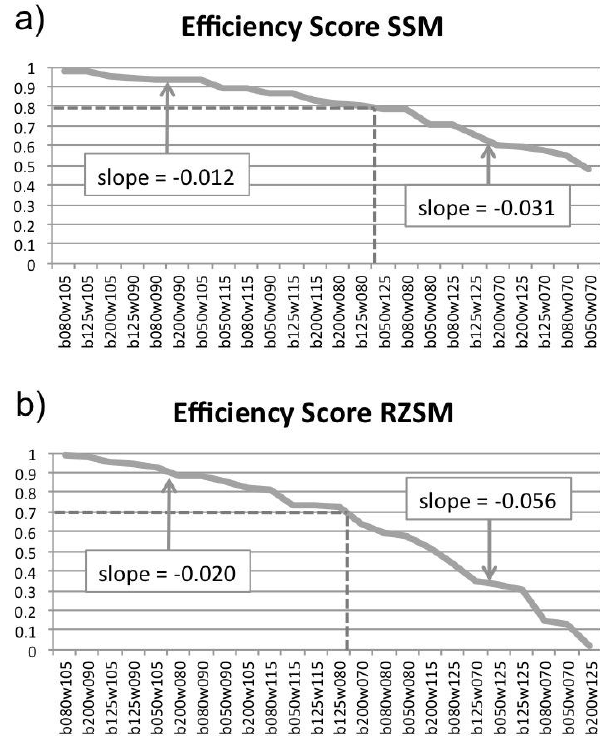
Fig. 4. Efficiency score for different combinations of the Clapp-Hornberger ( b ) and the soil wilting point wetness ( w ) parameter values for surface soil moisture (a) and root zone soil moisture (b). For example, the tag “ b080w105 ” on the x-axis corresponds to the combination that applies deviations of 80% and 105% to b and w respectively. The dashed line shows the cutoff threshold of acceptable efficiency scores.